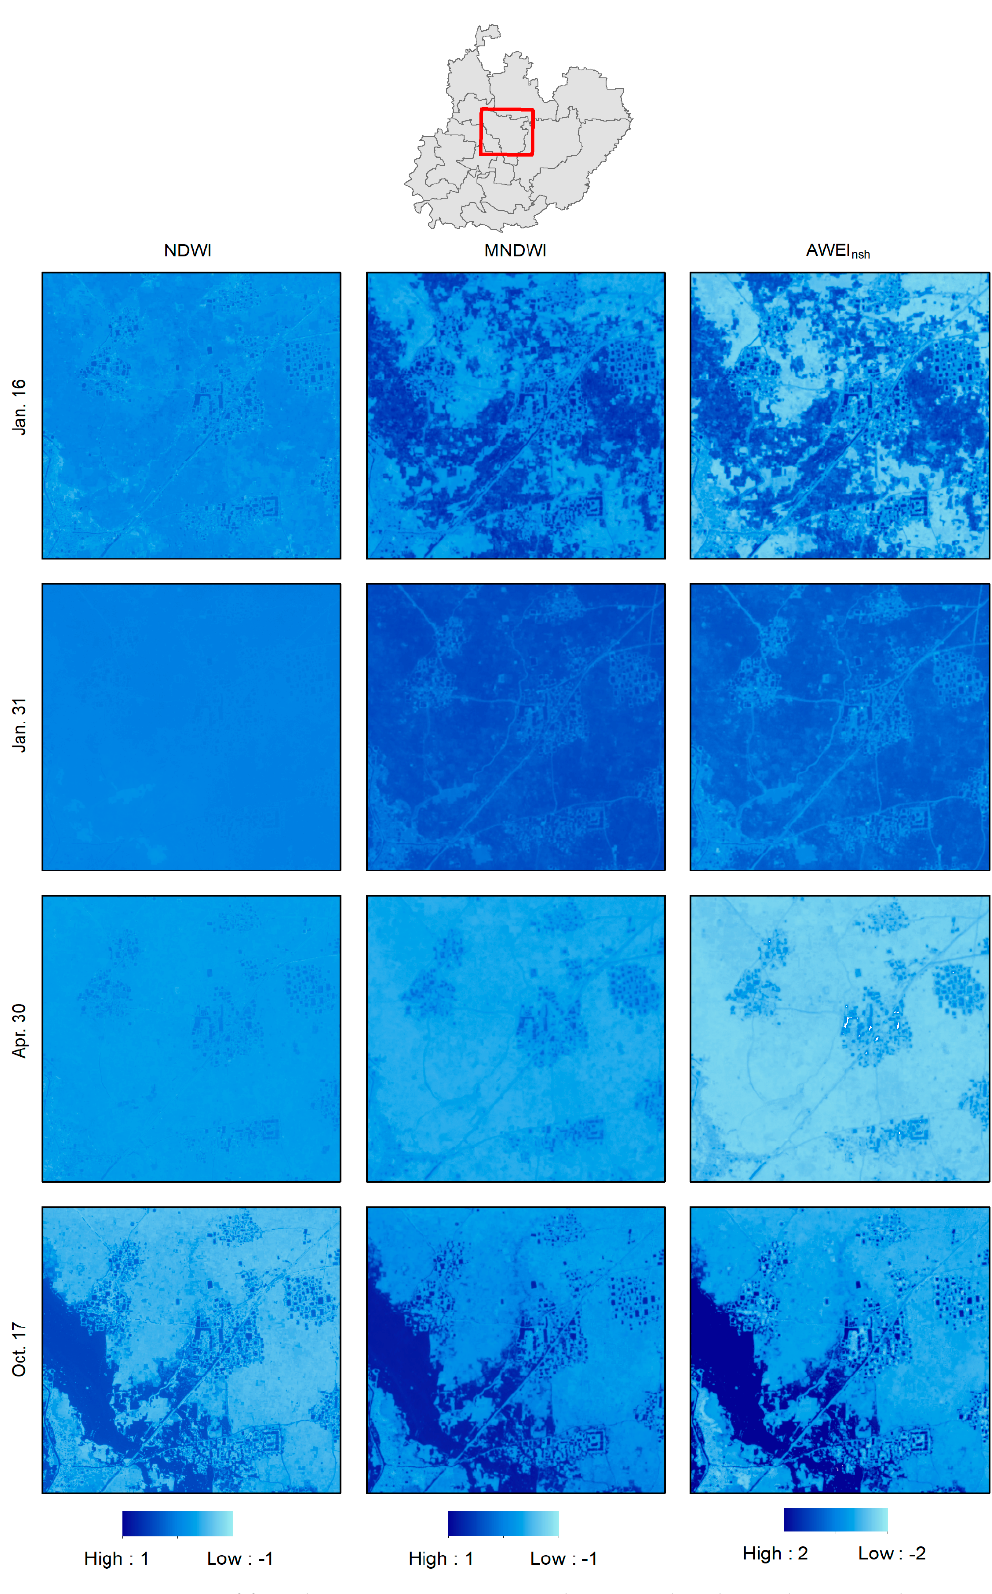
Figure 3. WI images of four dates in 2016 in an example area within the study area. Value ranges for Normalized Di ff erence Water Index (NDWI) and Modified Normalized Di ff erence Water Index (MNDWI) are − 1 to 1 and − 2 to 2 for AWEI nsh . No color stretches are applied. Higher WI values are shown in darker shade of blue.